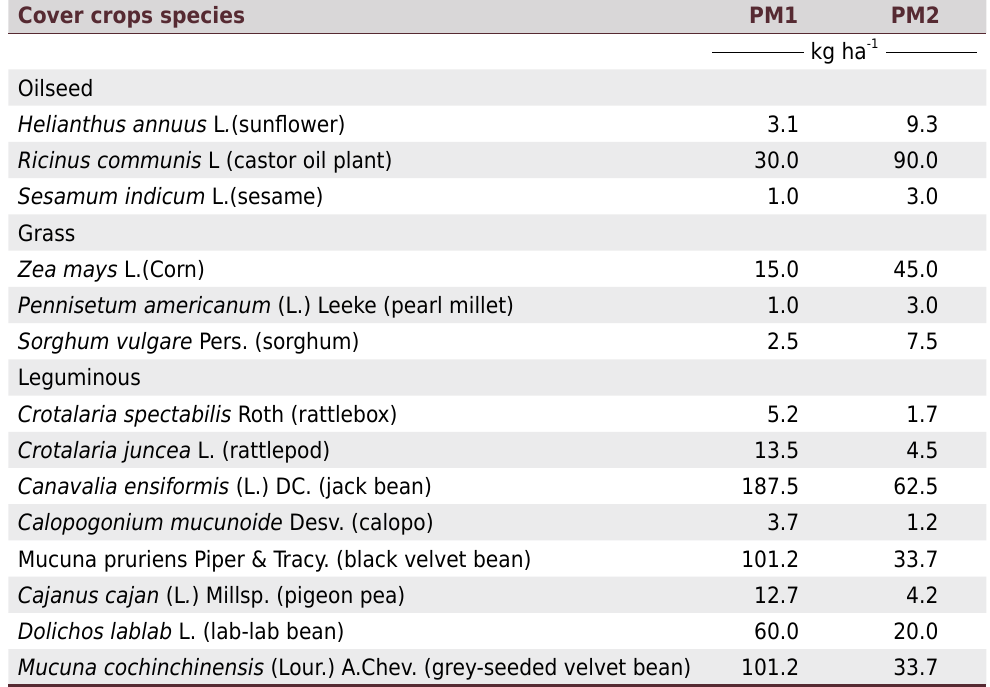
Table 1. Proportion of seeds used in the composition of two mixtures of cover crops in mango interrows: PM1 (75 % leguminous species + 25 % grass and oilseed species) and PM2 (25 % leguminous species + 75 % grass and oilseed species) Cover crops